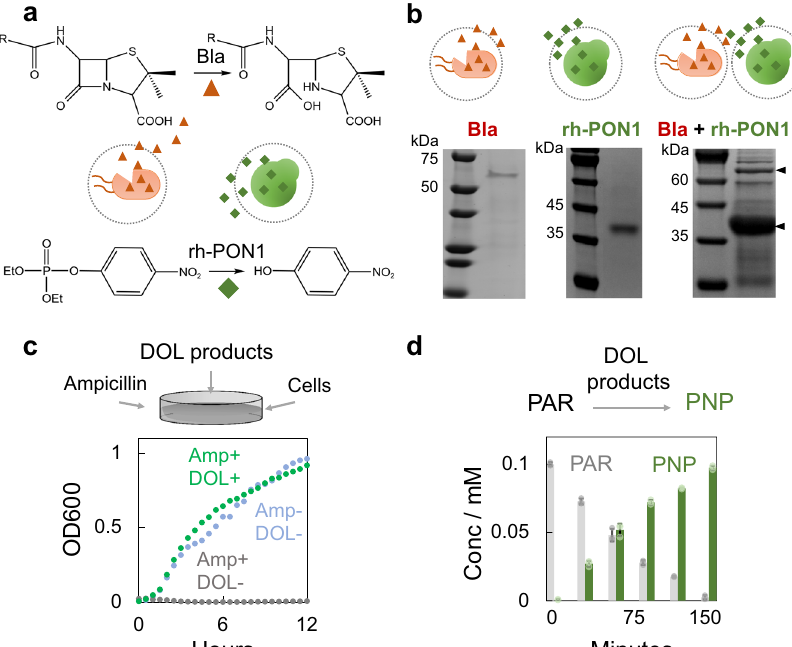
Fig. 5 MSBC platform enabled the controllable division of labor across the species. a Schematic shows that division of labor (DOL) product of the engineered MSBC can degrade both antibiotics and organophosphates. We engineered the MSB( E. coli ) that can release β -lactamase (Bla) through autonomous cell lysis, and the MSB( P. pastoris ) that can secret recombinant human paraoxonase (rh-PON1). The DOL product of MSBC contained both β - lactamase and rh-PON1, which could collectively degrade a broad class of β -lactams antibiotics by breaking the β -lactam ring and detoxify the organophosphate insecticides such as paraoxon by hydrolysis reaction. b MSBC produced both enzymes simultaneously. We cultured the MSB( E. coli ), MSB( P. pastoris ) or MSBC (containing both MSBs) in the nutrients for 48 h, collected the supernatants and puri fi ed for SDS-PAGE analysis. Results showed the presence of β -lactamase (Bla) or recombinant human paraoxonase (rh-PON1) manufactured by the individually cultured MSB( E. coli ) or MSB( P. pastoris ) (left and middle gel, 10 mL cell culture). Culturing the MSBC led to the simultaneous generation of two enzymes (right gel, 50 mL cell culture). Experiments were repeated independently more than three times with similar results. c DOL product of MSBC degraded antibiotics and rescued the cells. In all, 5 μ L puri fi ed enzymes mixture (from the supernatant of MSBC) was added into the 200 μ L LB medium with 300 μ g/mL ampicillin. Cells that are sensitive to the ampicillin (DH5 α ) were inoculated into the medium immediately (1:200 ratio) and the absorbance at 600 nm was monitored by a platereader. The growth of the rescued cells (green curve) was hardly in fl uenced and comparable with the control without adding antibiotics (blue curve). In contrast, the growth of the un-rescued cells was completely eliminated due to the presence of antibiotics (gray curve). d DOL product of MSBC converted the paraoxon (PAR) to paranitrophenol (PNP). The highly toxic PAR was hydrolyzed to PNP by the DOL product gradually. The concentration of PNP was quanti fi ed based on its absorbance at 405 nm. The consumption of PAR was then calculated based on the generation of PNP. Error bars = standard deviation ( n = 3 biologically independent samples). Source data are provided as a Source Data fi strain BL21(DE3) transformed with an inducible TagBFP plasmid was used to Bla was constructed using the synthesized fragment (His-ELPs-BlaM) from generate (Fig. 4d – f). Pichia pastoris X-33 was used for secretory protein expression Genewiz. The fragment was cloned into the vector with the T5 promoter and p15A (Figs. 2d and 5b – d). Saccharomyces cerevisiae BY4742 constitutively expressing eGFP origin. was used to generate (Figs. 2b and 4). Corynebacterium glutamicum ATCC 13032 Recombinant human growth hormone (rh-GH) and recombinant human carrying a plasmid (XK99E) that programmed the constitutive mCherry expression paraoxonase 1 (rh-PON1) were codon-optimized for expression in P. pastoris and was used to generate (Fig. 4d – f). E. coli strain MG1655 transformed with a plasmid CHP1 (pBAD-LasI)that producesthe3-oxo-C12-HSL(3OC12) under inductionwas used as the sender strain, and S. cerevisiae CYE72(BY4741 xylR natMX tetR lacI sensor strain) whose genome was integrated with the P lasO -YFP and the P tet -VP16- LasR operator was used as the receiver strain (Fig. 6) 51 . S. cerevisiae yCAN14that can use olivetolic acid to produce cannabigerolic acid was used to generate (Fig. 2e) 29 . Synechococcus elongatus PCC 7942 expressingsucrose permease (coded by cscB gene) under theinductionand E.coli MG1655 transformed withacircuitthat constitutively expressing the sucrose metabolism genes ( cscB (ECW_m2594), cscK (ECW_m2595) and cscA (ECW_m2596)) were used to generate (Fig. 7) 52 . Circuit and plasmids . ePop (ColE1 origin) was published previously 53 . Brie fl y, it was constructed using the luxbox region (140bp upstream of luxI in V. fi scheri ) from p lux GFPuv and E gene coding sequence from φ X174 (NEB). Each region was PCR-ampli fi ed and then joined together in an overlap PCR reaction. The “ lux box- E gene ” fragment was inserted into the AatII site of host vector pLuxRI2. Elastin-like polypeptide (ELP)-fused GFP-His was constructed using the plasmids from Prof Chilkoti ’ s lab. The fragments were cloned into the vector with the T7 promoter and p15A origin. The 34 translation machine genes were synthesized by Genewiz and cloned into the vector with a T7 promoter and p15A origin with a 6×His-tag located at either the N or C terminal 15 .